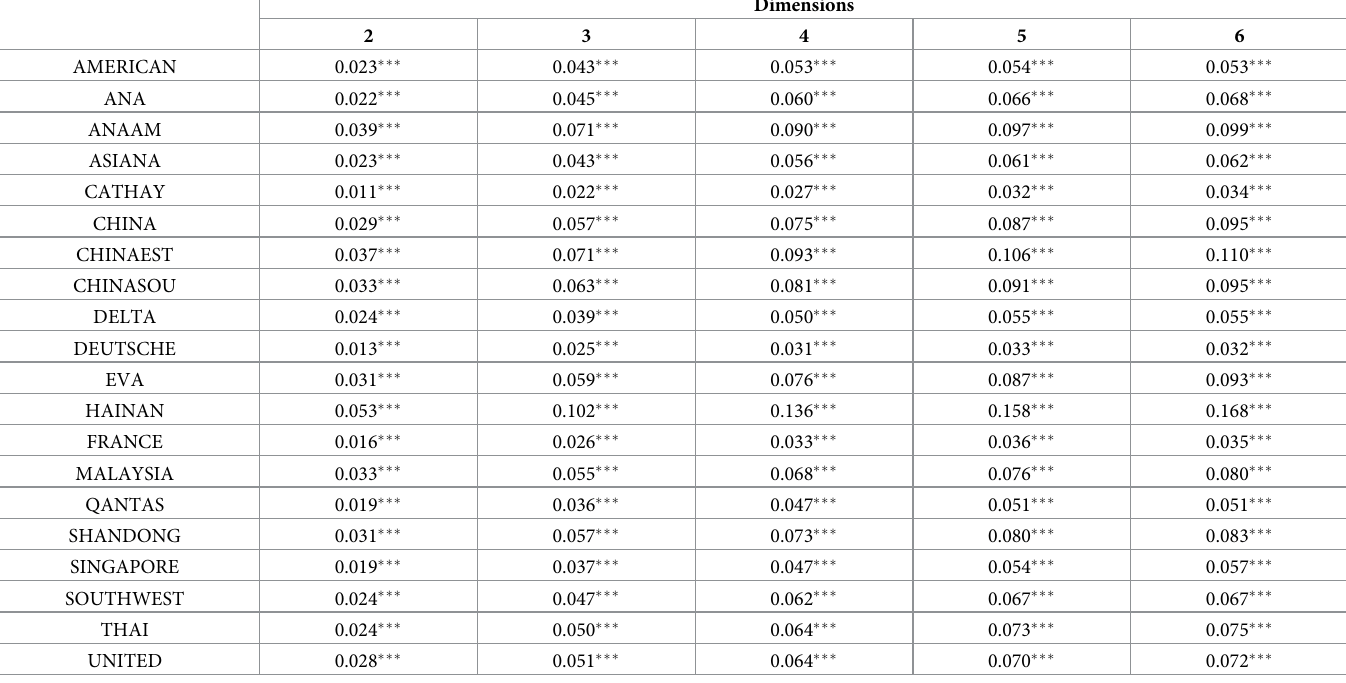
Table 3. Brock et al. (1996)—(BDS)